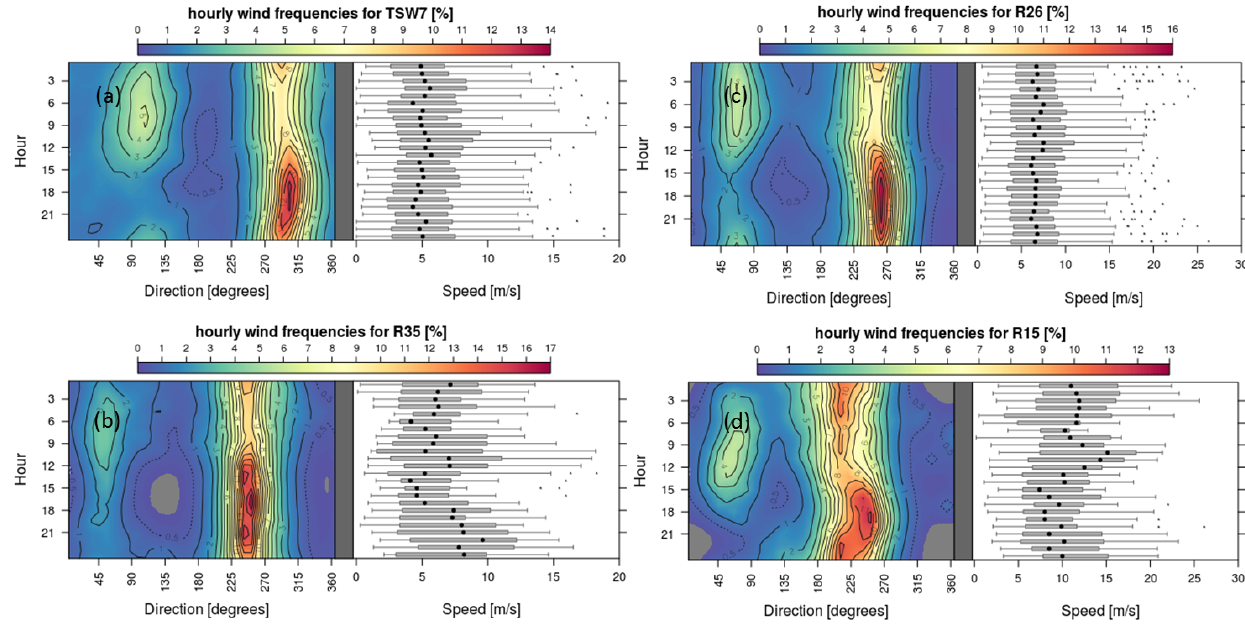
Figure 9. Contour plots of hourly wind frequencies and corresponding wind speeds for four ridgetop locations at Big Southern Butte. Periods of strong synoptic forcing were removed from these data.